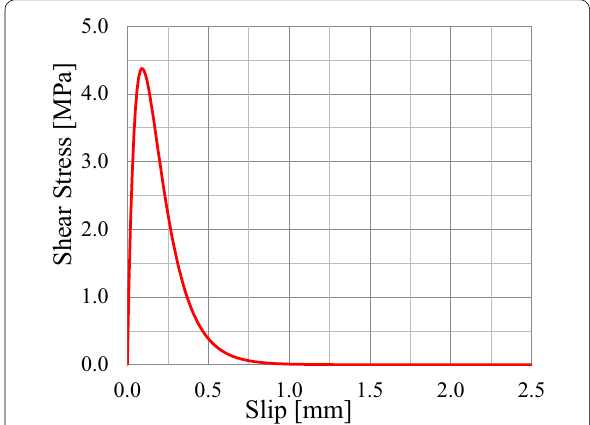
Fig. 12 Bond-slip relationship for SRP-concrete joints with MD fibers determined from the experimental